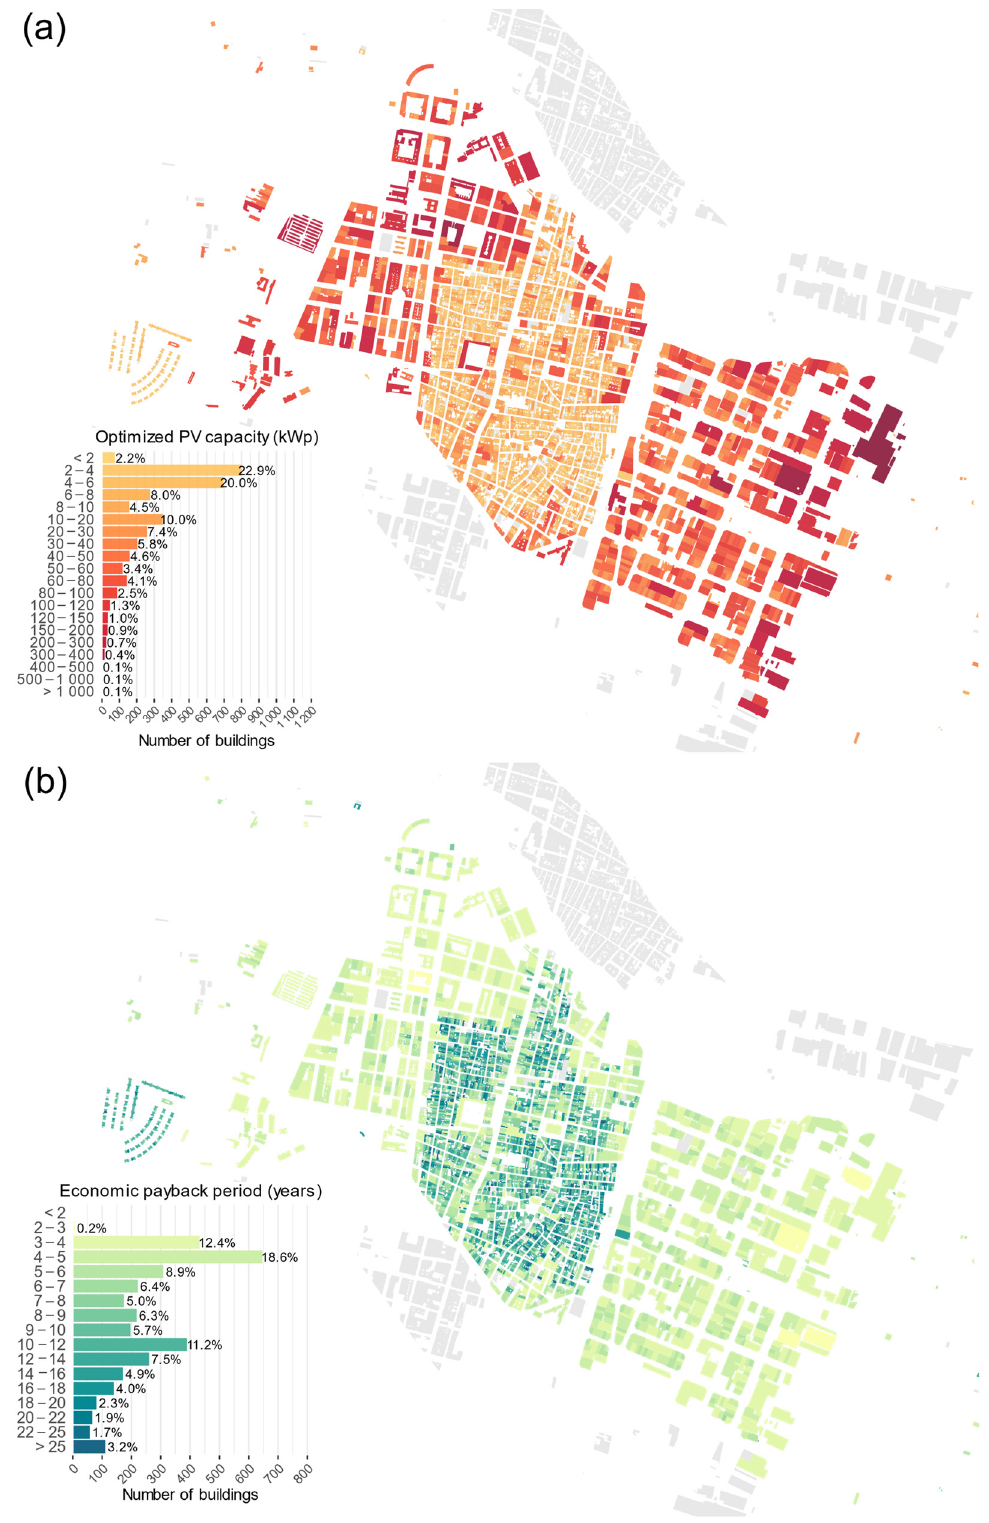
Figure 4. Spatial distribution in the municipality and histograms of ( a ) optimal capacity and ( b ) economic payback of the facilities for the base scenario.